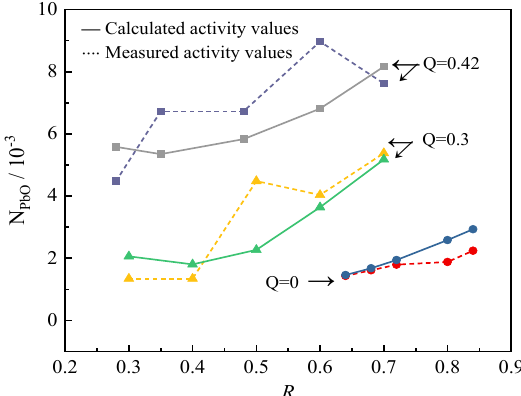
Figure 1. Calculated and measured activity values of PbO.